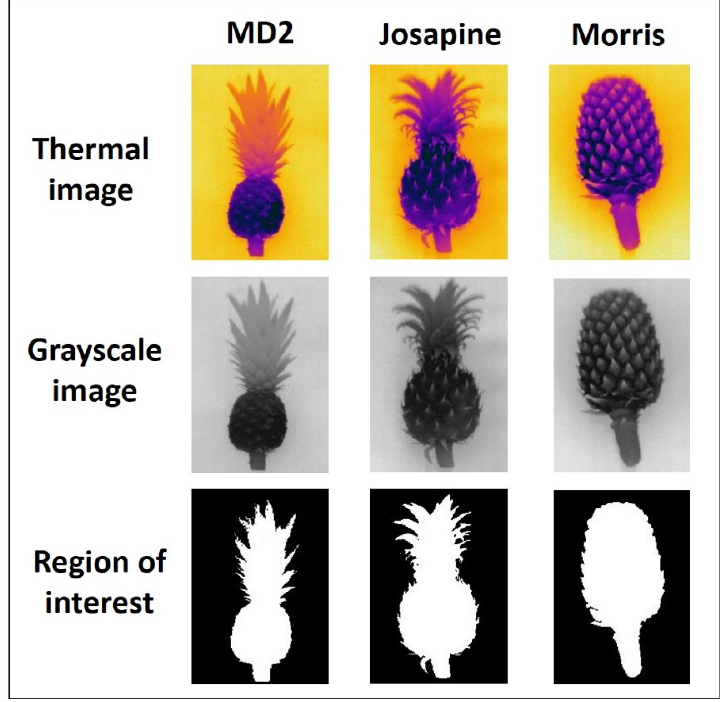
Figure 2. Thermal image analysis using image segmentation processes.